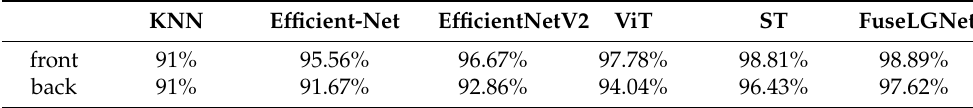
Table 2. Results from gait energy maps using the GAIT-IST dataset.